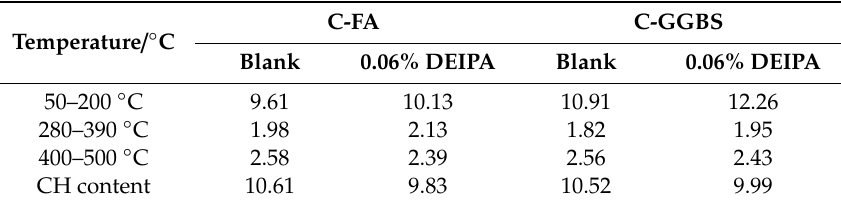
Table 5. Loss weight of C-FA and C-GGBS hydrated for 60